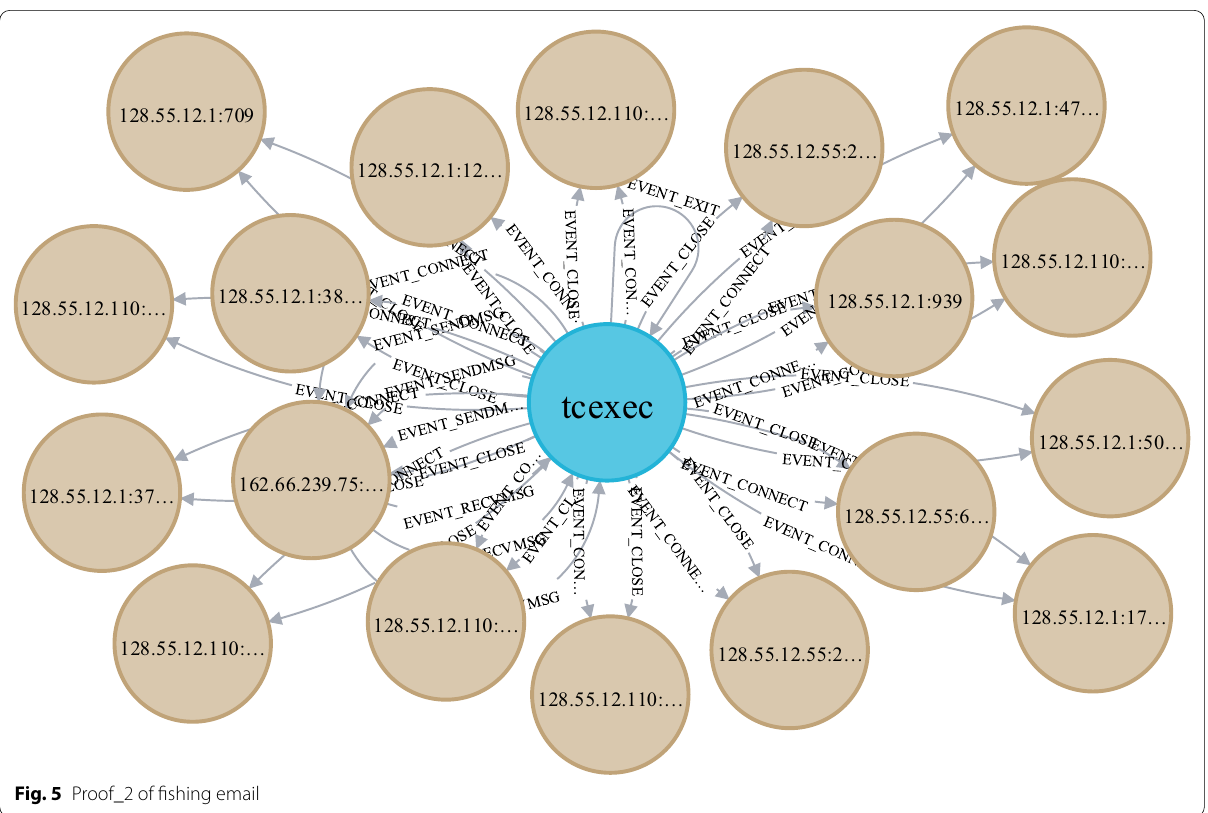
Fig. 5 Proof_2 of fishing